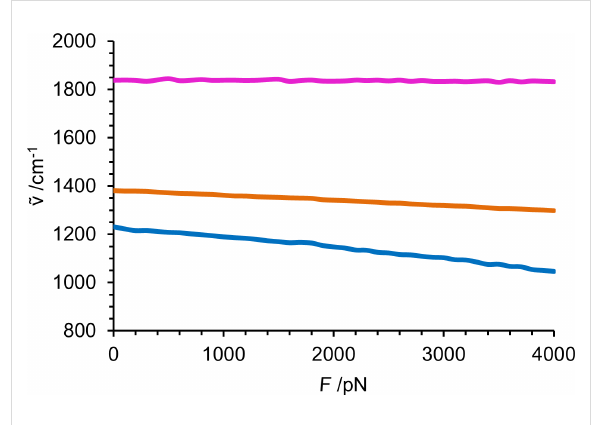
Figure 4: Force dependence of the modes shown in Scheme 2 in the fingerprint region from 800 to 2000 cm − 1 . C–O backbone stretch of the ester bond (blue); backbone stretch combined with C–H 2 wagging (orange); free C-O stretch (purple).